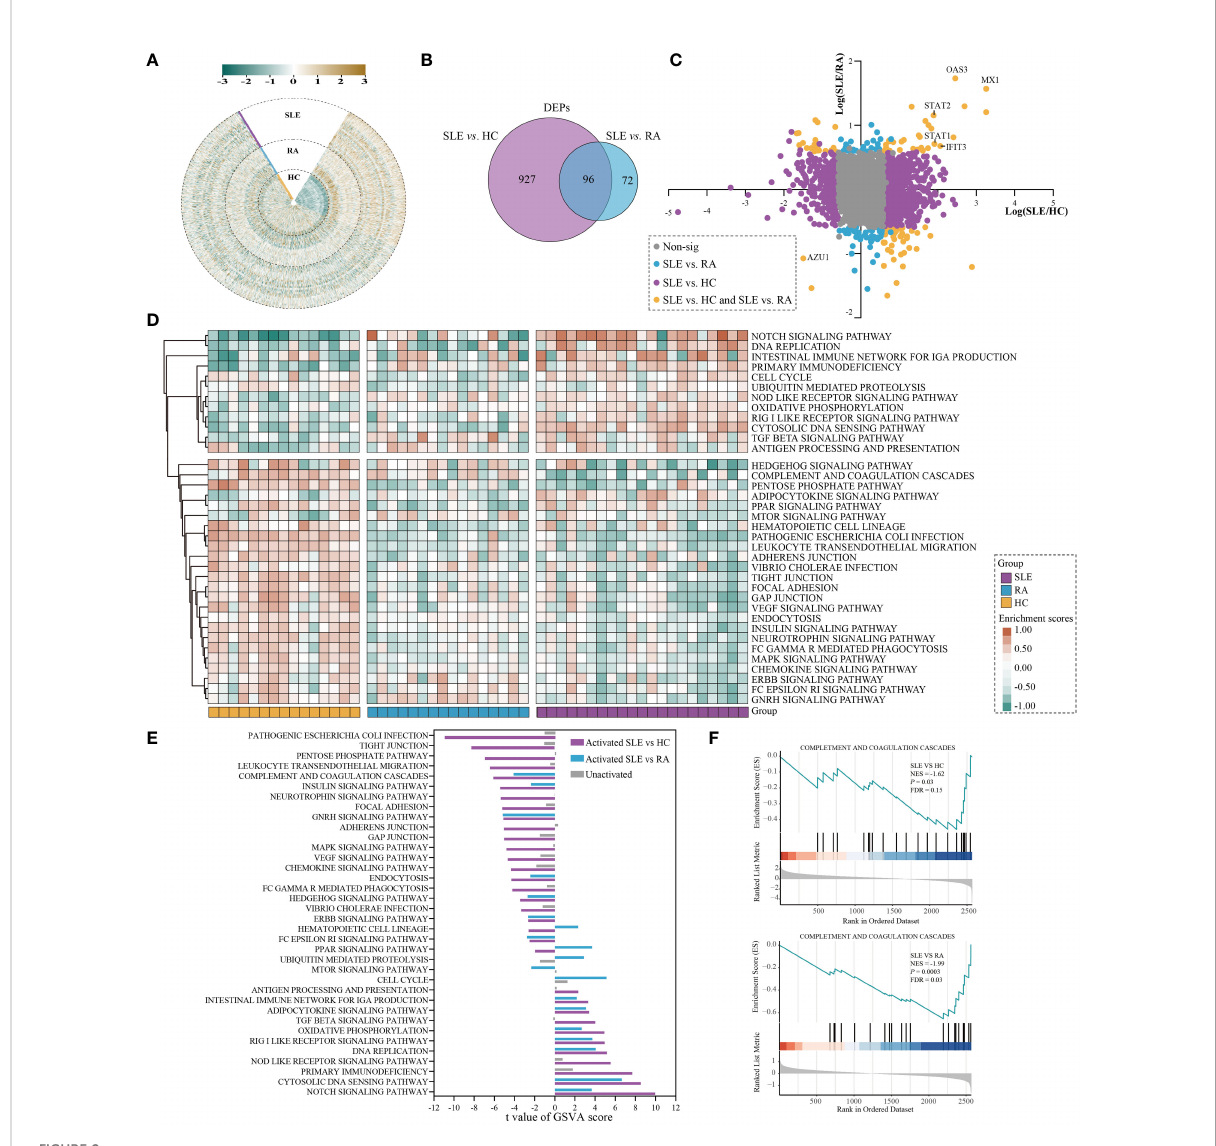
FIGURE 2 Differential analysis in protein expression levels between SLE and HC or RA. (A) The heatmap for the expression of PBMC proteins in SLE, RA, and HC. The expression of each proteins was normalized by Z score normalization. (B) Venn diagram summarising the differential and overlapping proteins between SLE and HC or RA (fold change(FC) > 1.5 or < 0.67, unpaired two-sided Student ’ s t-tests, P < 0.05). (C) Plots of fold changes of differentially expressed proteins in SLE vs. RA only, SLE vs . HC only, and SLE vs . both. (D) The enrichment score for 36 KEGG pathways by GSVA in SLE, RA, and HC. The brown and green nodes represent upregulation and downregualtion state of pathway, respectively (moderated t-test, P < 0.05). (E) The differentially activated KEGG pathways between SLE vs. RA and SLE vs. HC. The blue and purple bands represent the activated pathways of SLE vs. RA and SLE vs. HC, respectively; and the gray bands represent the unactivated pathway. (F) GSEA of complement and coagulation cascades gene sets were signi fi cantly differentially enriched between SLE and HC or RA (permutation test, P <